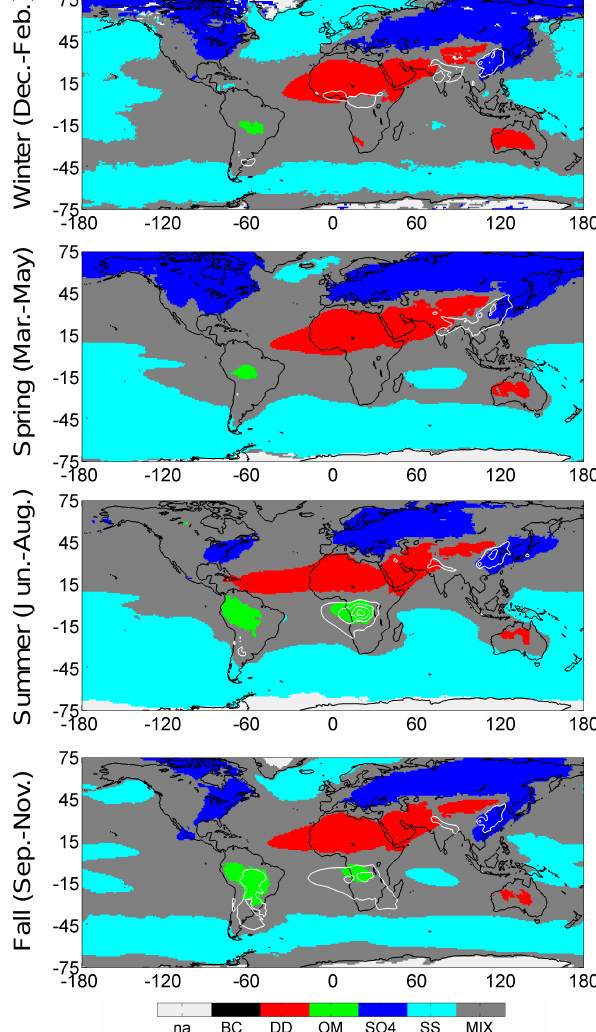
Figure 9. Seasonal cycle of global main aerosol type distribution ac- cording to MACC. Data are from 2007–2011 and were divided into the four main seasons (from top to bottom): winter, spring, sum- mer, and fall. Aerosol types are black carbon (BC), mineral dust (DD), organic matter (OM), sulfate (SO 4 ), sea salt (SS), and mix- ture (MIX). Light gray areas (na) are not analyzed due to too small mean AOD. As BC does not dominate anywhere, contours show mean BC amount (AOD 0.02–0.1) to indicate regions affected by smoke; see text for